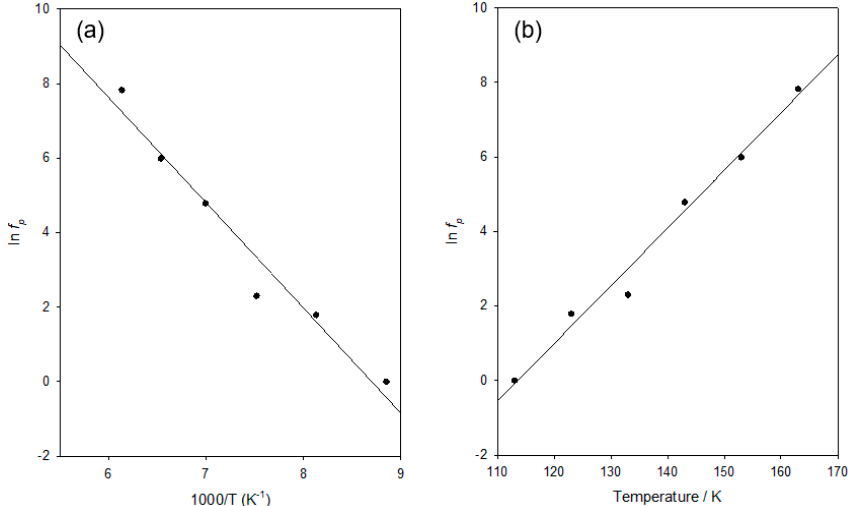
Figure 4. Temperature, T , dependence of the estimated dielectric γ relaxation peak frequency, f p , plotted according to the: ( a ) Arrhenius equation and ( b ) thermally activated tunnelling.